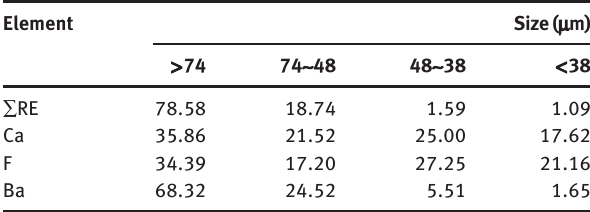
Table 5: Elemental